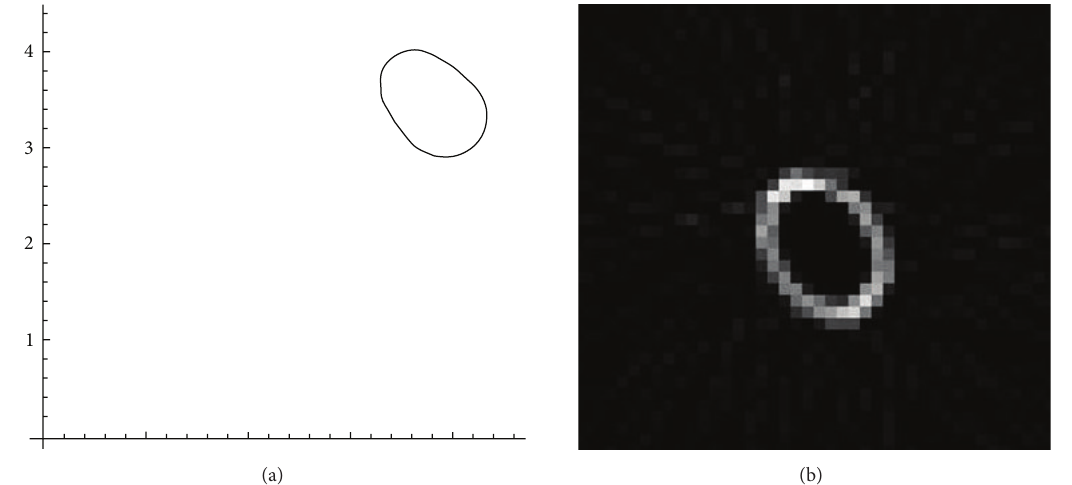
Figure 10: Analysis of artifacts caused by the offset of an isocenter and the deflection of linear detectors: (a) the trajectory of 𝑀(𝛽) ; (b) the reconstruction image.